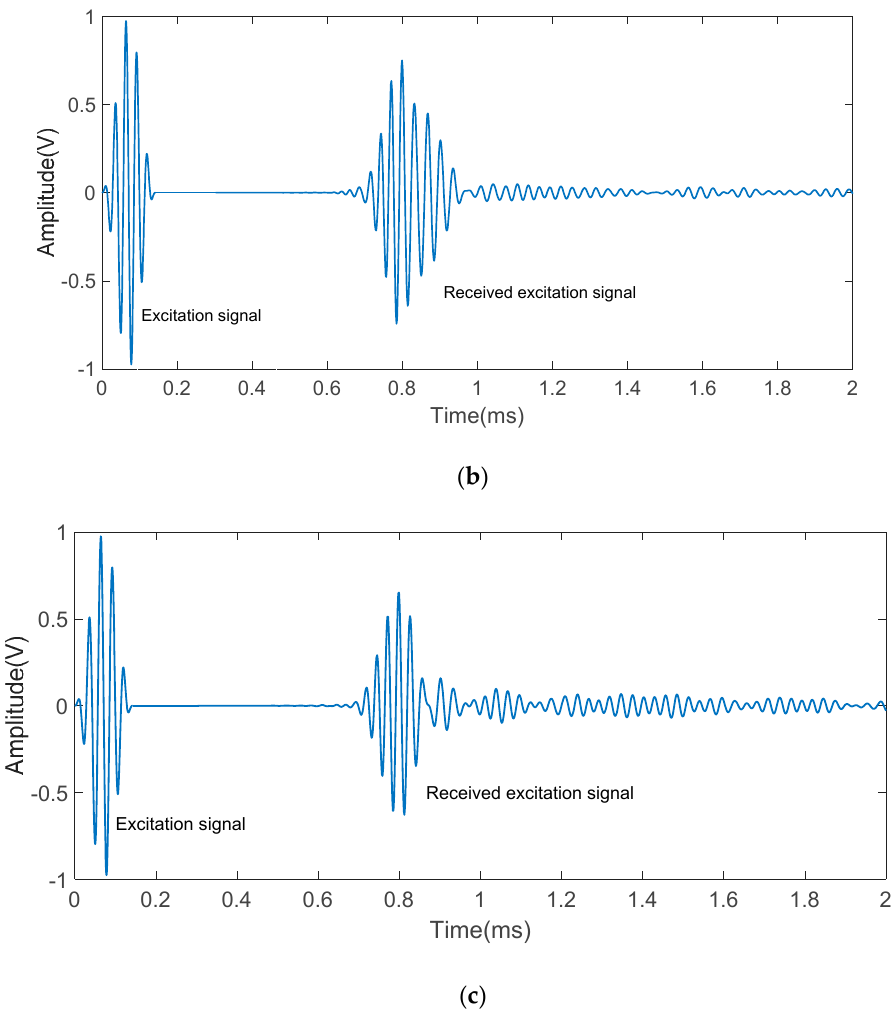
Figure 16. Rail head defect detection. ( a ) Mode 7 rail head defect detection; ( b ) mode 3 rail head defect detection; ( c ) mode 1 rail head defect detection.